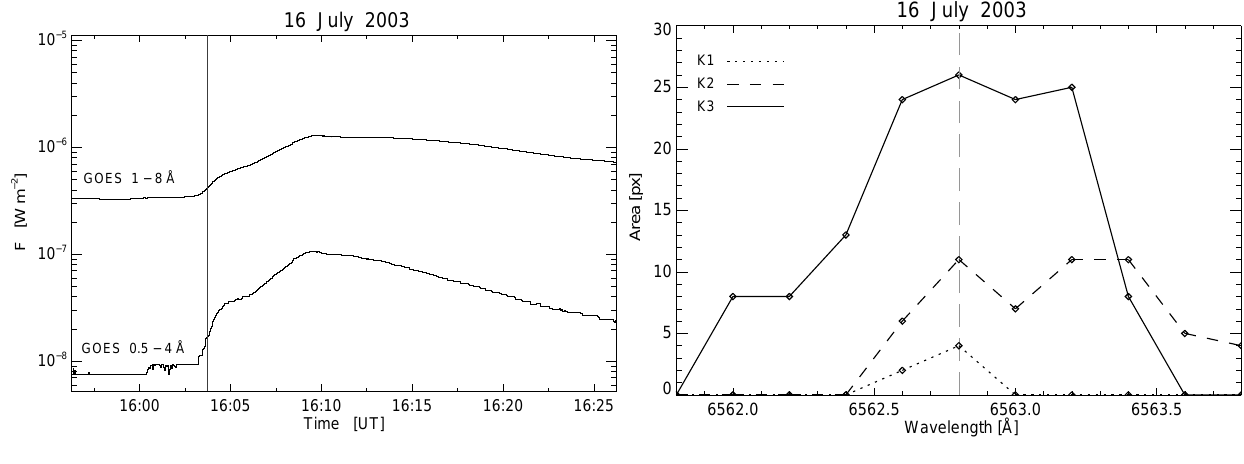
Fig. 2. Areas of the K1, K2 and K3 flaring kernels of the C1.2 class solar flare at 16:03:45UT on 16 July 2003. Left panel: X-ray GOES fluxes in 0.05–0.4nm and 0.1–0.8nm bands recorded during the flare. The vertical line marks 16:03:45UT. Right panel: areas of the K1, K2 and K3 flaring kernels (in pixels) measured simultaneously in various wavelengths in a frame of the H α line profile (up to ± 1.0 ˚A from the H α line center). The vertical dashed line points the H α line